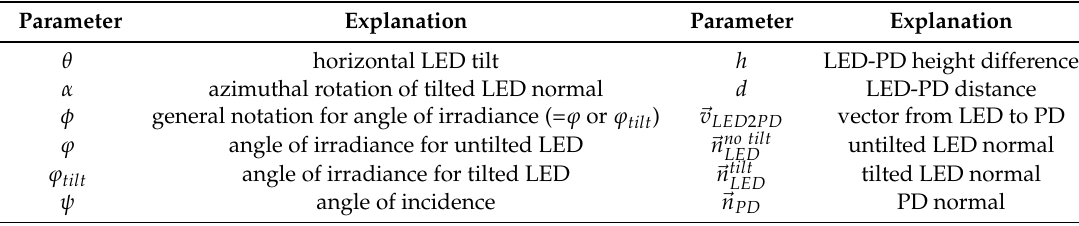
Table 1. Summary of the parameters defined in Figure